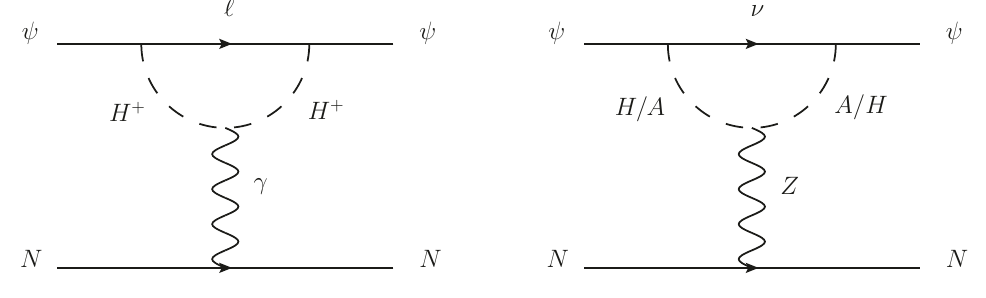
Figure 8 . Leading contributions to SI DM-nucleon scattering via photon-penguin (left) and Z - penguin (right) diagrams. There are similar diagrams with the photon and Z boson attached to the lepton lines instead of the extra